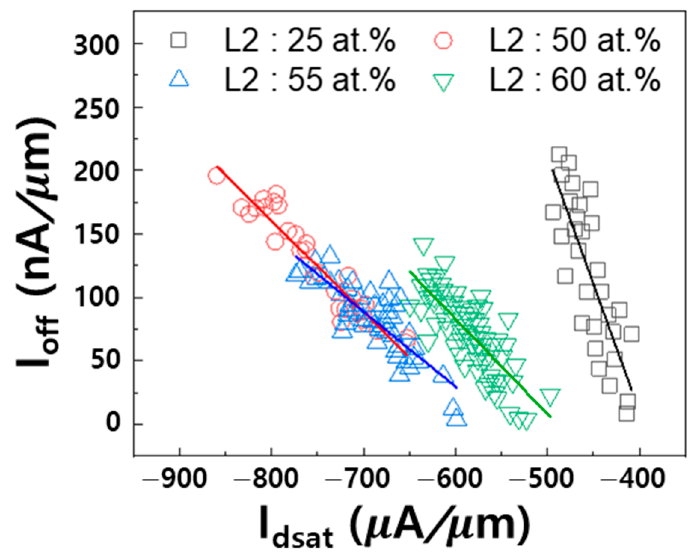
Figure 5. I off versus I dsat for 28-nm-logic p-MOSFET with various C Ge of L2 in SiGe of embedded S/D.